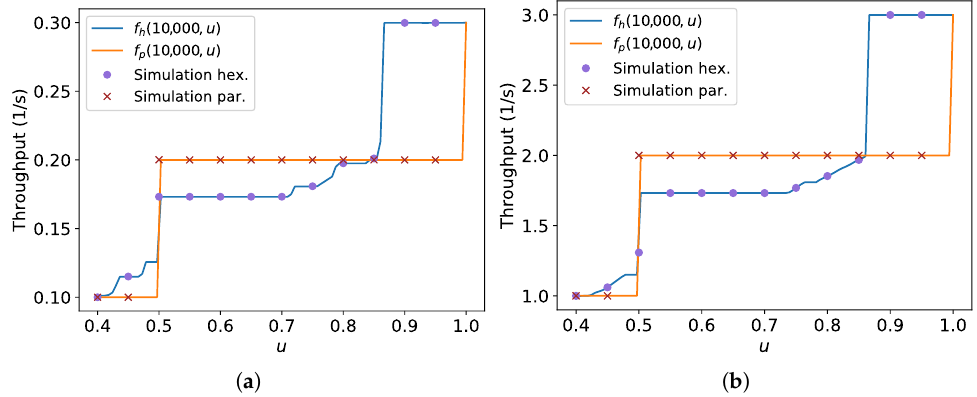
Figure 43. Throughput versus ratio u = s / d comparing hexagonal packing and parallel lanes strate- gies for v ∈ { 0.1,1 } m/s, including results from Stage simulations. ( a ) v = 0.1 m/s; ( b ) v = 1 m/s.